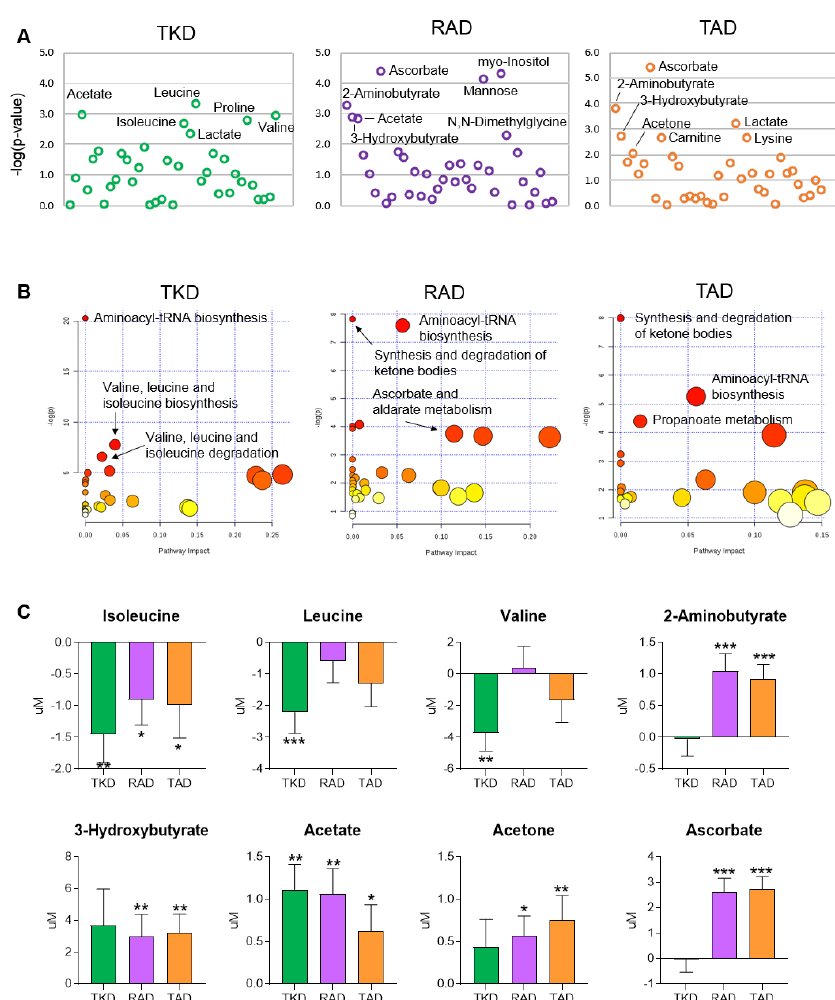
Figure 3. Global profiling analysis of serum metabolites. Metabolomic profiles of serum samples were determined by 1 H NMR. ( A ) Significantly changed metabolites between before and after dietary intervention using Wilcoxon Signed-Rank test. Metabolites with raw p < 0.01 ( − log 10 of the p -value > 2) are labeled. ( B ) Significant metabolic pathways affected by diet intervention using Metaboanalyst pathway analysis. The color and size of the circles reflect the p -values and pathway impact values, respectively. ( C ) Alterations in the concentrations of metabolites. The vertical axis shows the alternation of metabolite concentration, which is the delta value between concentration of sample from before each diet and sample from after each diet (C After minus C Before ). p -value of significant differences between the levels before and after each dietary pattern were determined from the Wilcoxon Signed-Rank test. *, **, and *** indicate p < 0.05, p < 0.01, and p < 0.001, respectively.